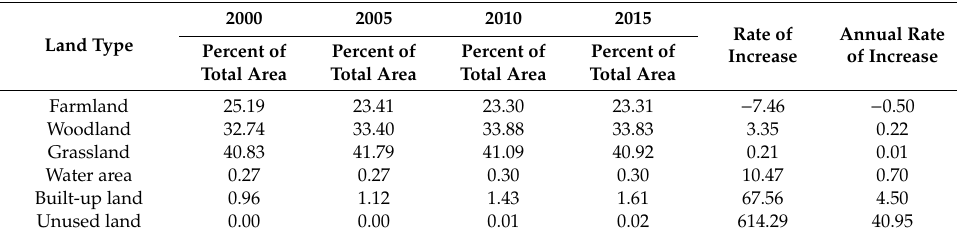
Table 4. Land use changes in Shangzhou district from 2000 to 2015.